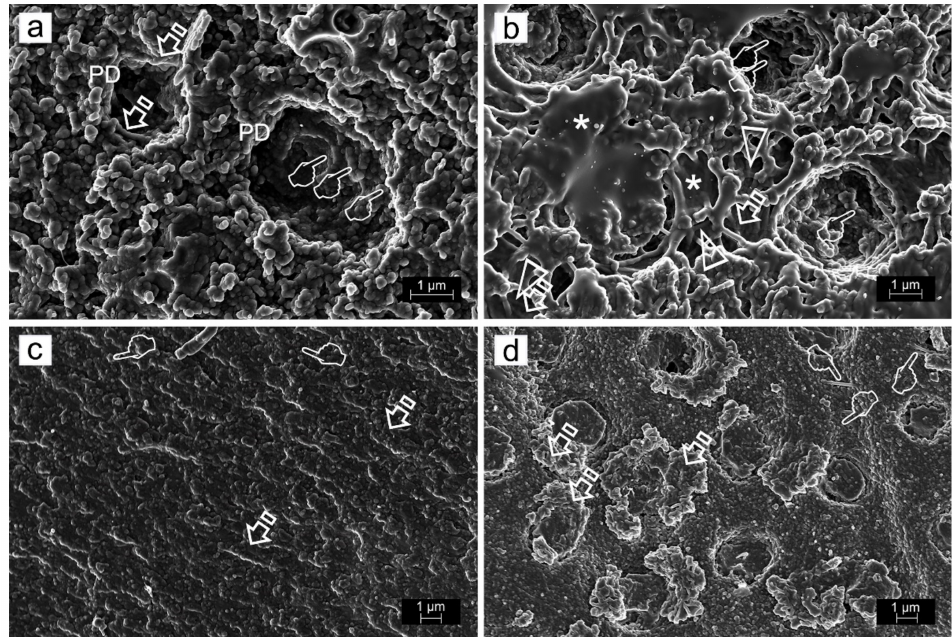
Figure 4. Field-emission scanning electron microscopy images of failures after bonding and mi- crotensile bond strength testing. ( a ) The bonding component of the Clearfil SE Bond self-etching system doped with ZnO (SEB.Bd-ZnO) showed a mixed failure at the bottom of the hybrid com- plex. Tubules appeared mineral filled. ( b ) SEB.Bd-ZnO produced a mixed failure, affecting both the adhesive surface (asterisk) and the partially demineralized dentin (arrow) at the bottom of the hybrid complex. Mineralized dentin collagen without resin infiltration was detected inside some tubule wall, where crystals precipitated in knob-like formations (pointers). Multiple collagen fibrils appeared longitudinally mineralized (arrow heads). ( c ) The primer component of the Clearfil SE Bond self-etching system doped with ZnCl 2 (SEB.P-ZnCl 2 ) permitted to observe a mixed failure at the bottom of the hybrid complex. Multiple mineral formations are observed emerging through the resin–dentin infiltrated layer (arrows). ( d ) SEB.Bd-ZnCl 2 originated a mixed failure at the top of the hybrid complex. A mineral deposition is completely covering the dentin surface. This substratum resulted totally mineralized and the mineral formations only allowed a restricted display of the tubule entrances (arrows). The typical staggered pattern of collagen fibrils due to the characteristic D- periodicity (67 nm) was visible at the fibers which cover the intertubular dentin